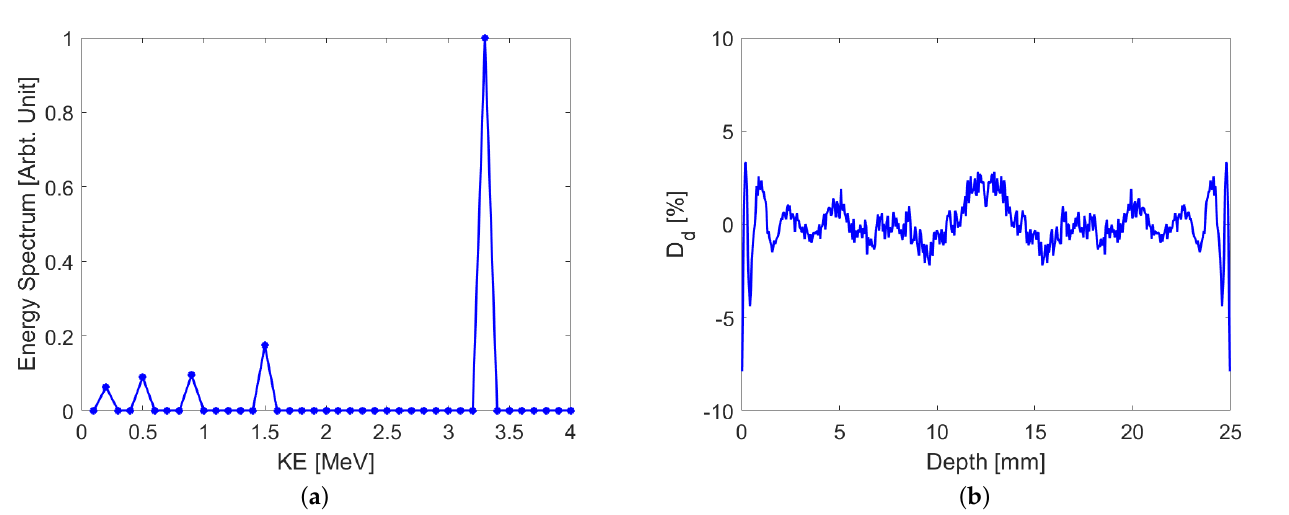
Figure 9. ( a ) The kineetic energy (KE) spectrum for multi-pass, multi-energy irradiation of ( b ) the hide and the resulting dose deviation. The spectrum is obtained by using the least-squares algorithm and limiting the combination to five mono-energetic